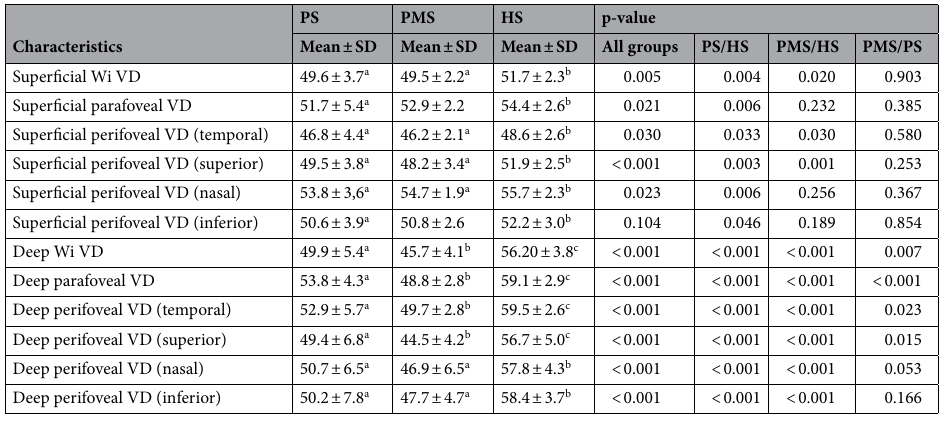
Table 3. Comparison of quantitative OCTA measurements between psoriasis group, metabolic syndrome and controls. PS psoraisis group, PMS psoraisis and metabolic syndrome, HS healthy control, Wi Whole image, VD Vessel density. There was a statistically significant difference between a variable with a different letter, no significant difference between a variable with the same